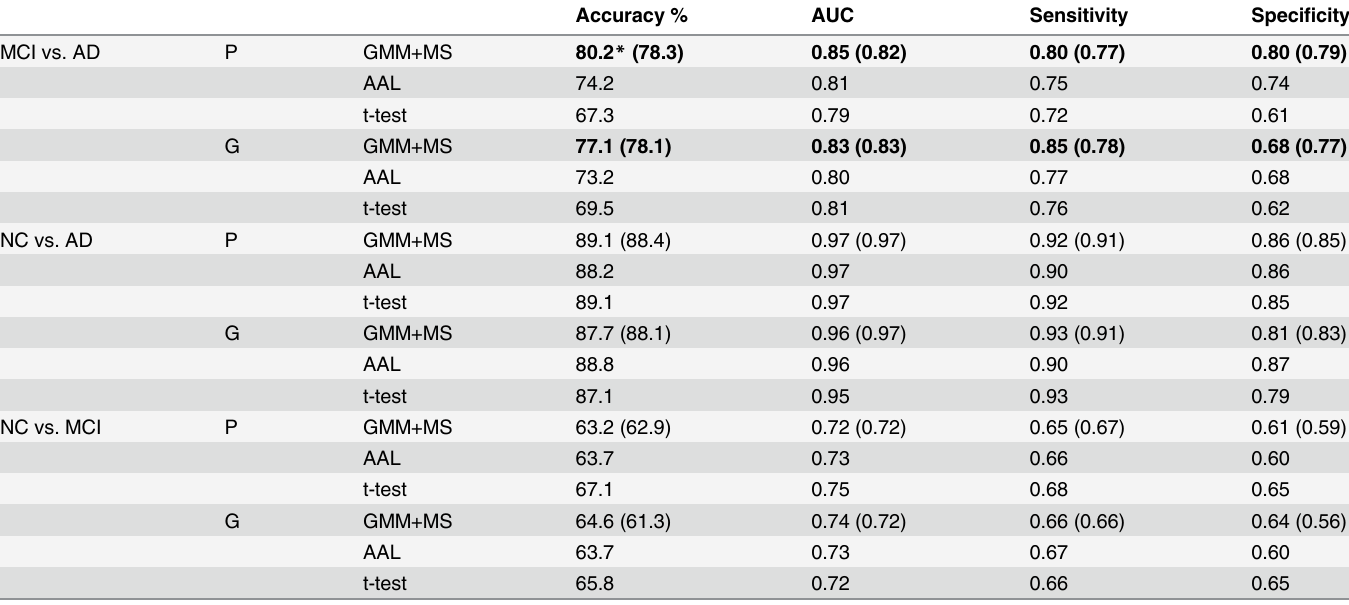
Table 4. Result summary of three different methods on ADNI